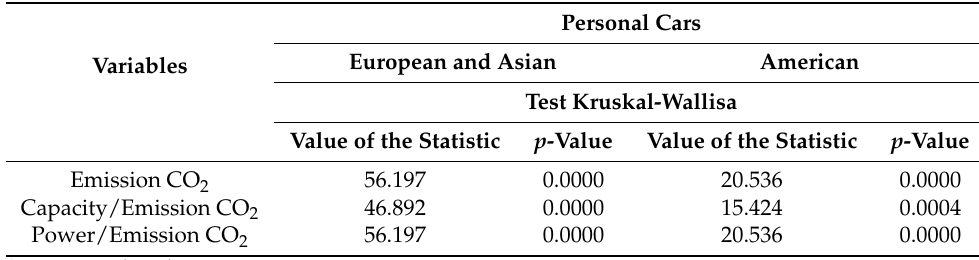
Table 4. Verification of the statistical significance of differences in the levels of variables between car categories.